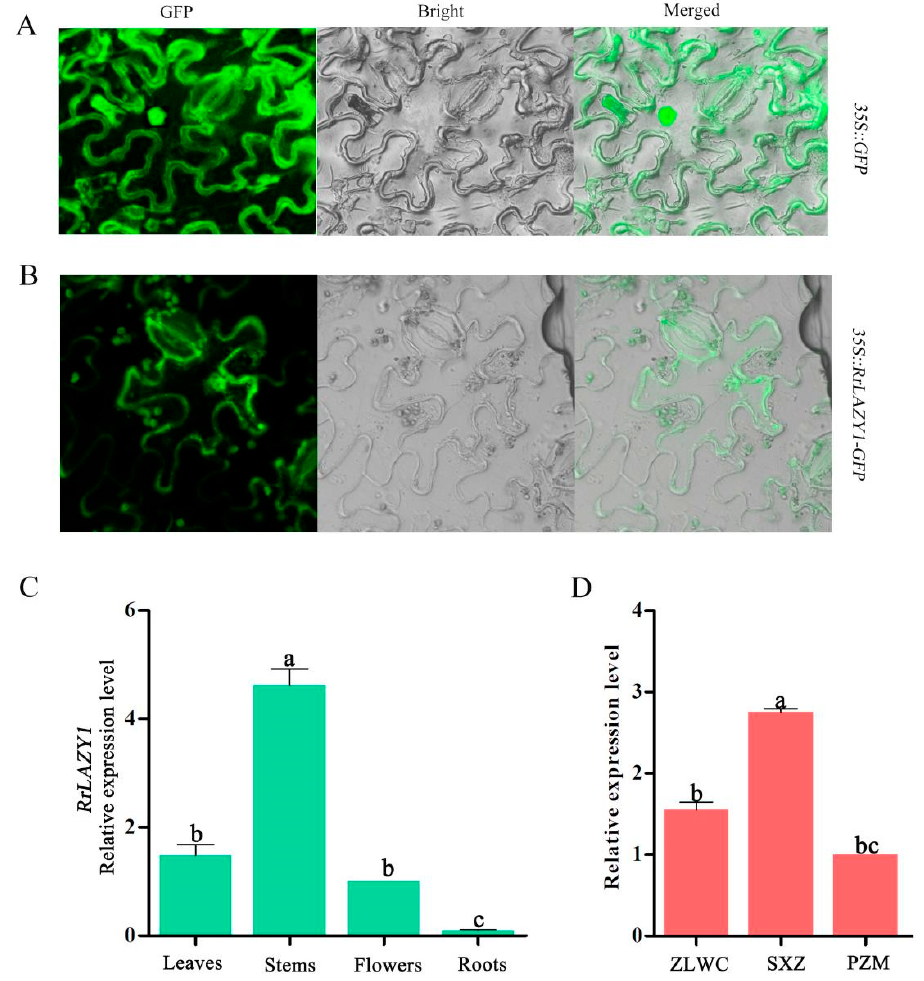
Figure 3. The expression characteristics of RrLAZY1 . ( A , B ) Subcellular localization analysis of the RrLAZY1 gene. The 35S::RrLAZY1-GFP fusion vectors were transiently expressed in the epidermal cells of tobacco leaves with 35S::GFP vectors as a control. GFP, GFP fluorescence; Bright, bright field; Merged, superimposition of bright field and fluorescence. ( C ) The relative expression level of the RrLAZY1 gene in different tissues of R. rugosa ‘Zilong wochi’. ( D ) The relative expression level of RrLAZY1 gene in the stems of R. rugosa of two architecture types. SXZ, R. rugosa ’Saixizi’; ZLWC, R. rugosa ’Zilong wochi’; PZM, R. rugosa ’Pingzhimei’. Different lowercase letters indicate significant differences at p < 0.05.